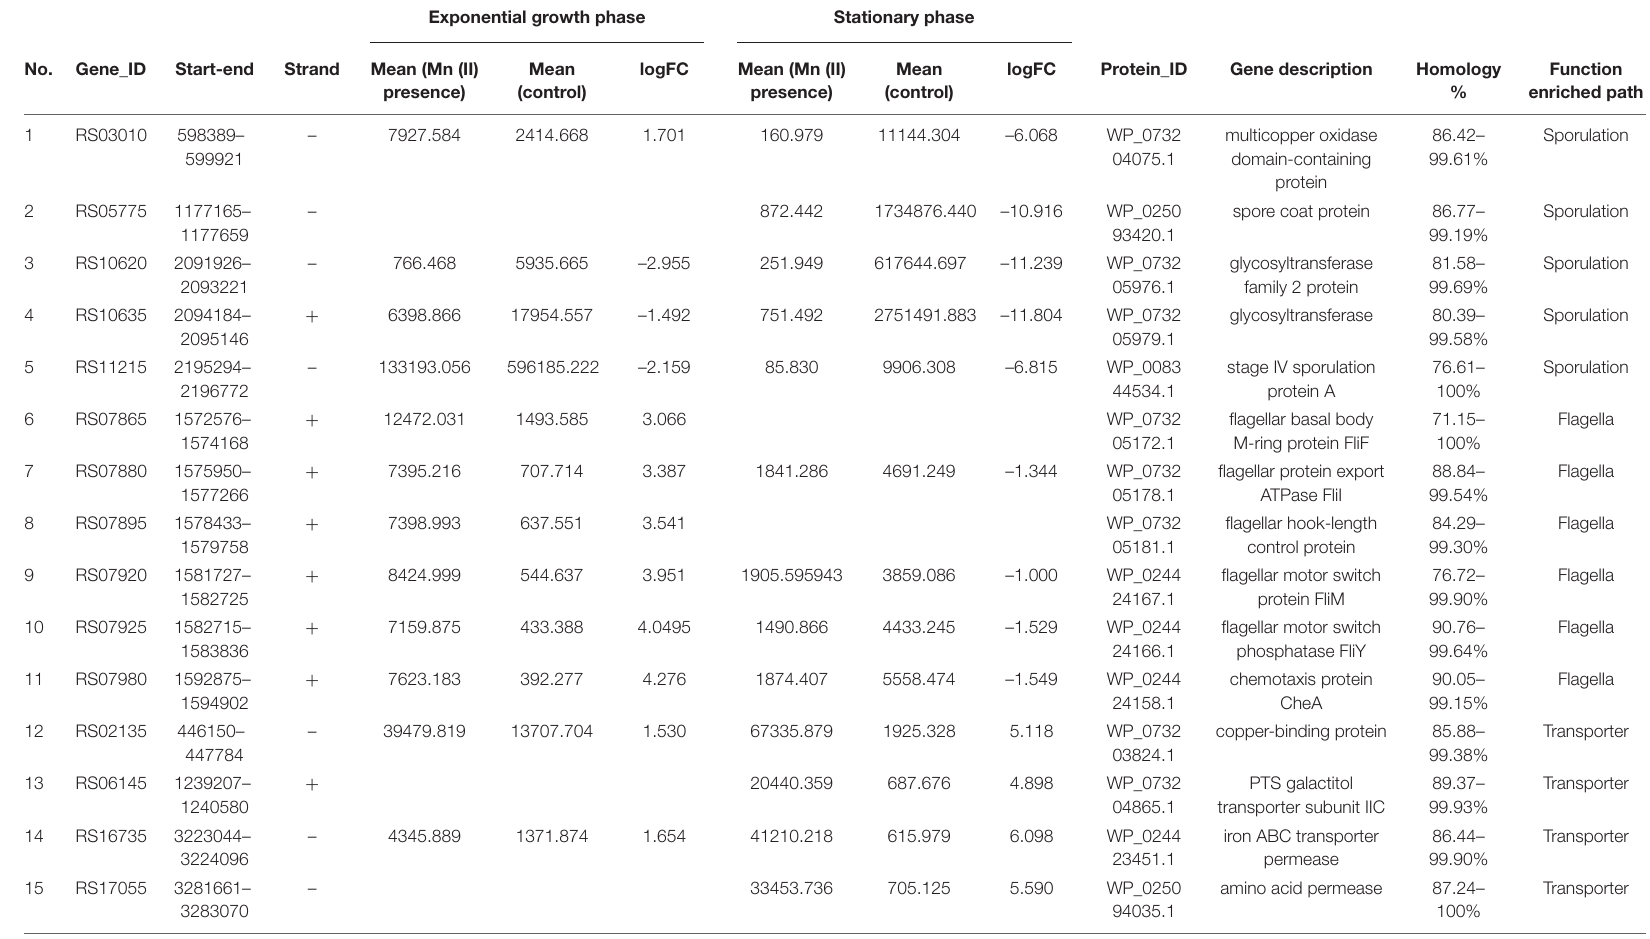
TABLE 4 | Information of fifteen genes knocked out via homologous recombination